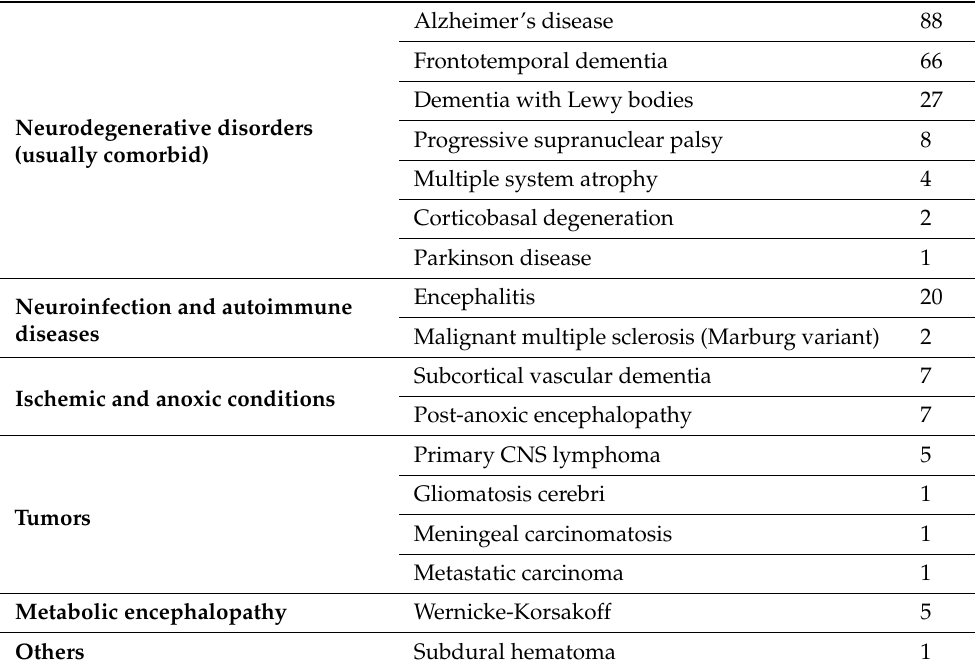
Table 5. Autopsy findings of non-prion diseases from brain tissue samples described as possi- ble/probable CJD